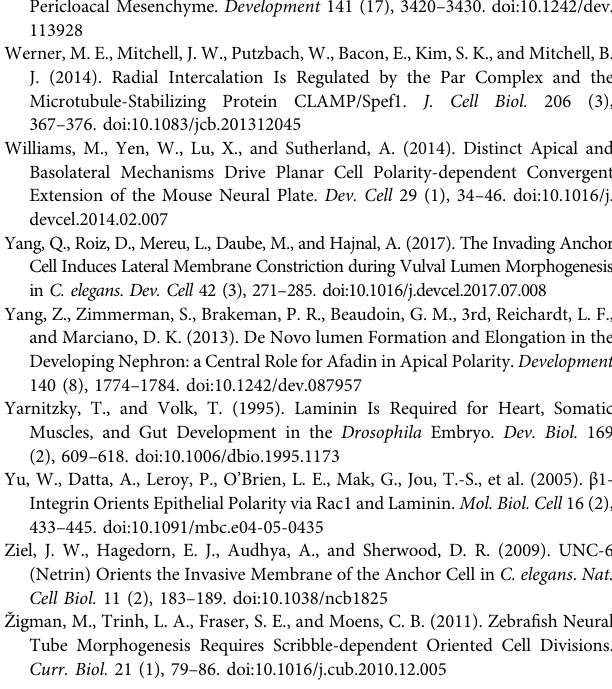
Tabler, J. M., Bolger, T. G., Wallingford, J., and Liu,K. J. (2014). Hedgehog Activity Controls Opening of the Primary Mouth. Dev. Biol. 396 (1), 1 – 7.